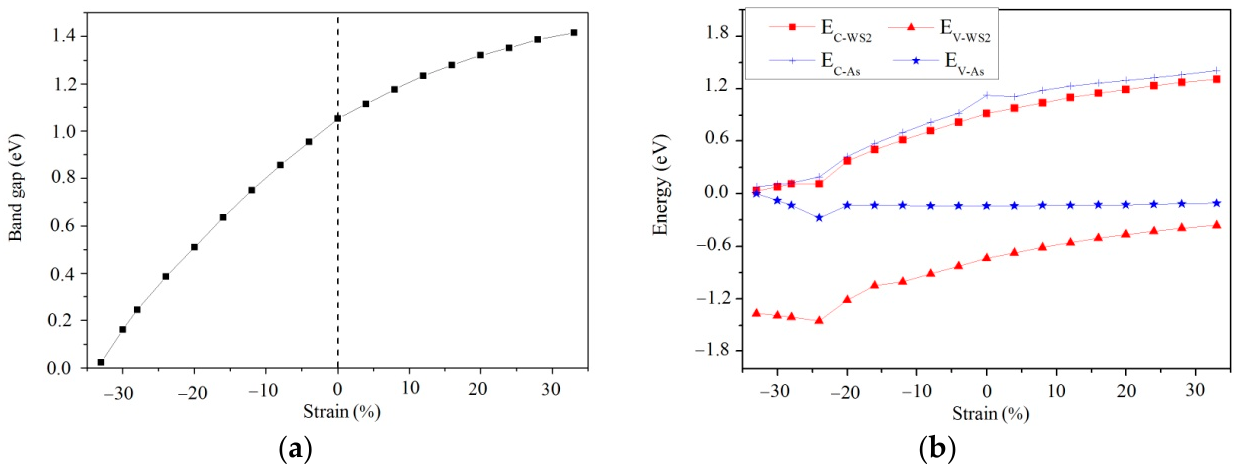
Figure 6. The band gap ( a ) and band edge ( b ) of the arsenene/WS 2 heterostructure under various out-of-plane strains. E C-WS2(As) and E V-WS2(As) are the CBM and VBM of WS 2 (arsenene) in the arsenene/WS 2 heterojunction.